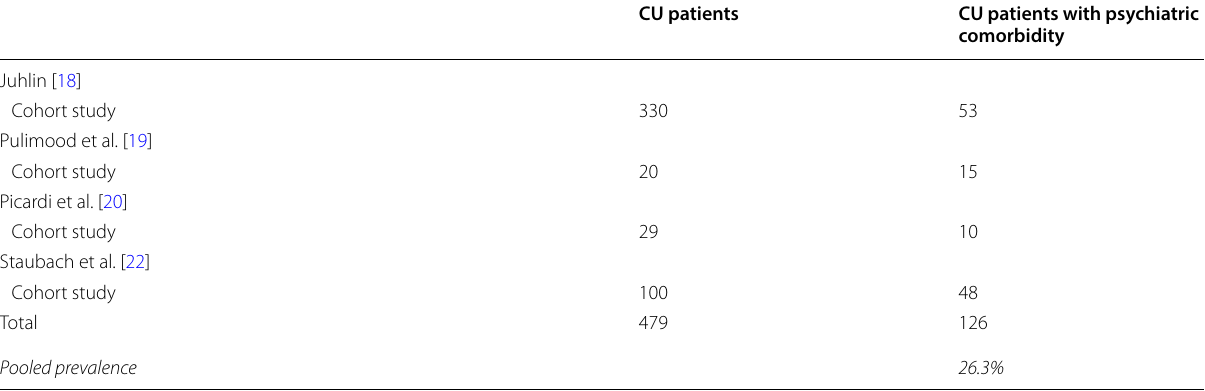
Table 2 Psychiatric comorbidity in chronic urticaria patients—studies not including a control